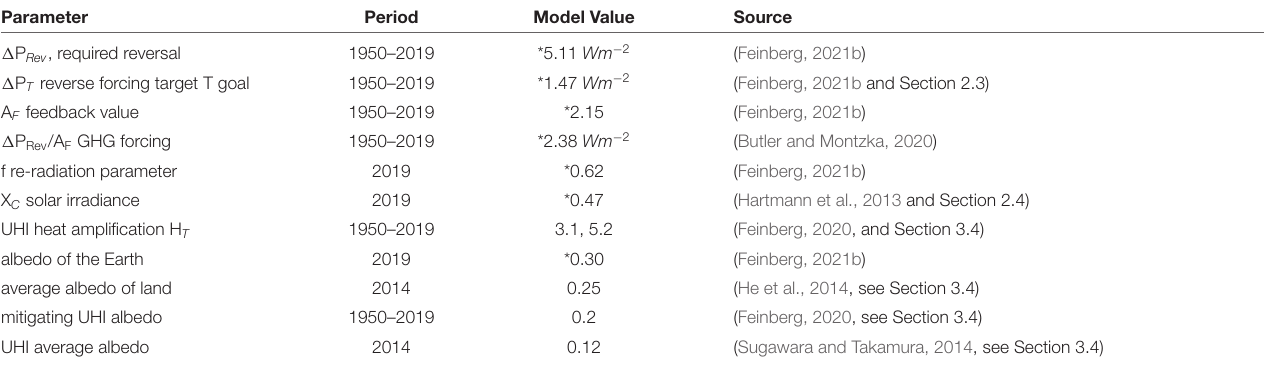
TABLE 1 | Suggested model GMEEB * estimates and other